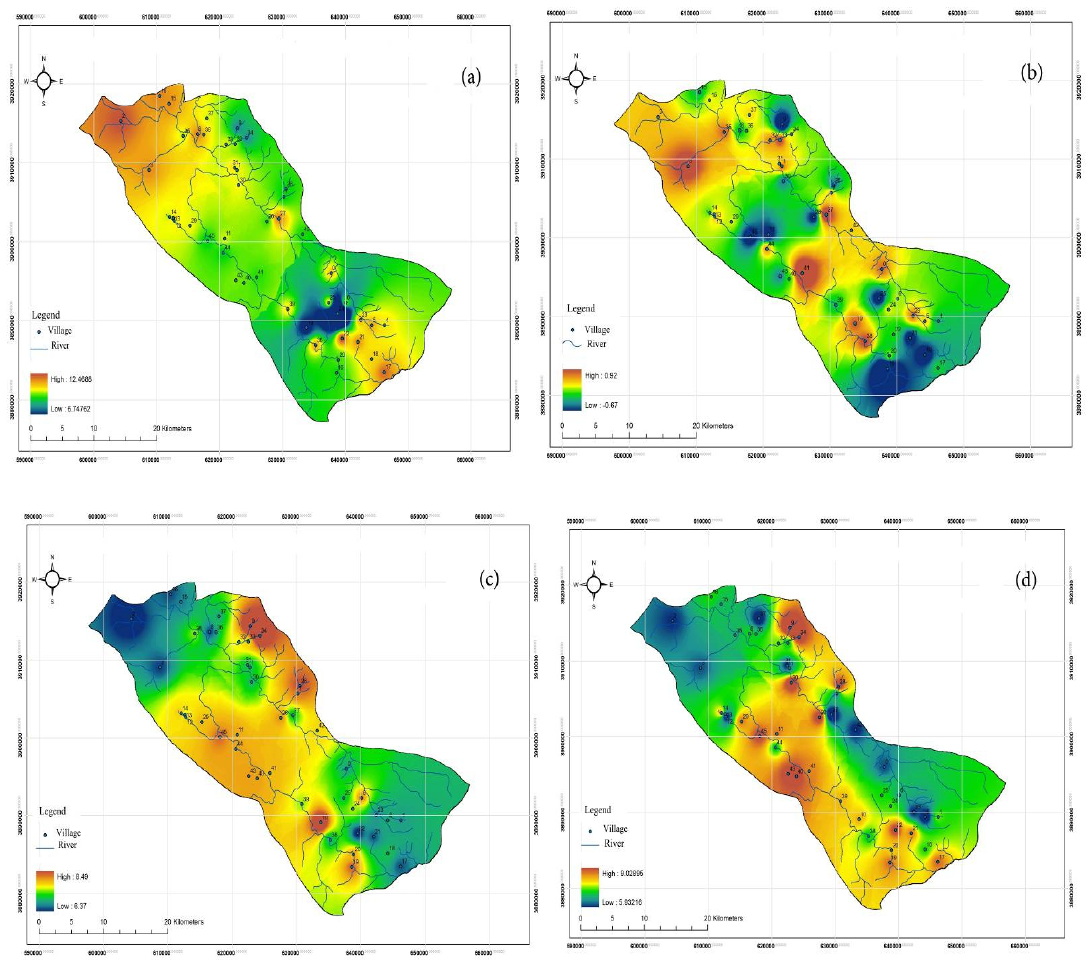
Fig. 3. Spatial distribution of water resources based on different indices during a high rain season (spring): a) AI, b) LSI, c) RI, and d)